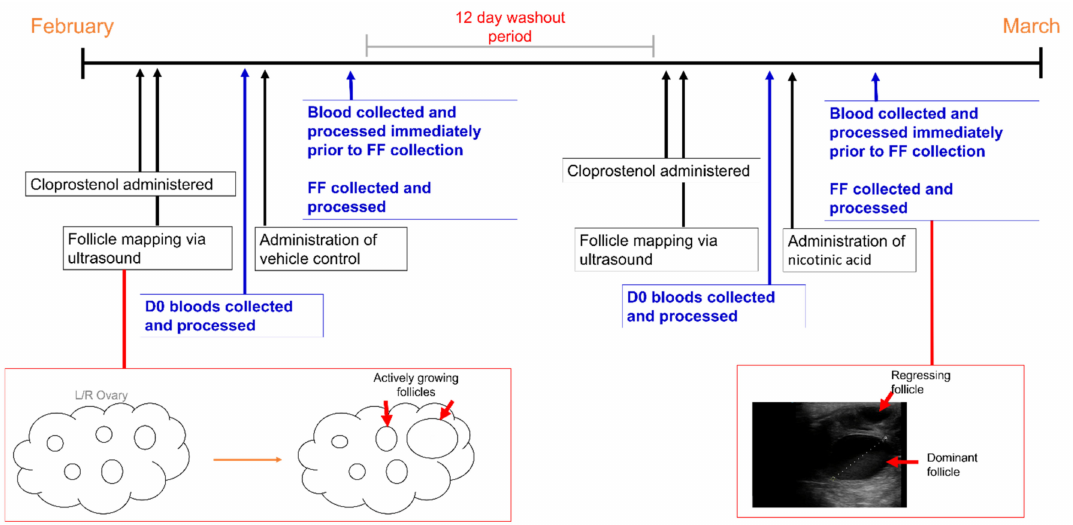
Figure 2. A timeline of events for the study period. The study was conducted in February and March, towards the end of the equine breeding season in Australia. Cloprostenol was administered to all mares to synchronise oestrus. Follicles were mapped daily via transvaginal guided ultrasound to identify regression of the corpus luteum and the beginning of active follicle growth. Blood samples were collected prior to any treatments being administered, followed by the administration of the vehicle control or nicotinic acid. Once a dominant follicle ( ≥ 25 mm in diameter) was identified, feeding ceased, and blood and follicular fluid were collected and processed approximately 16 h after the final